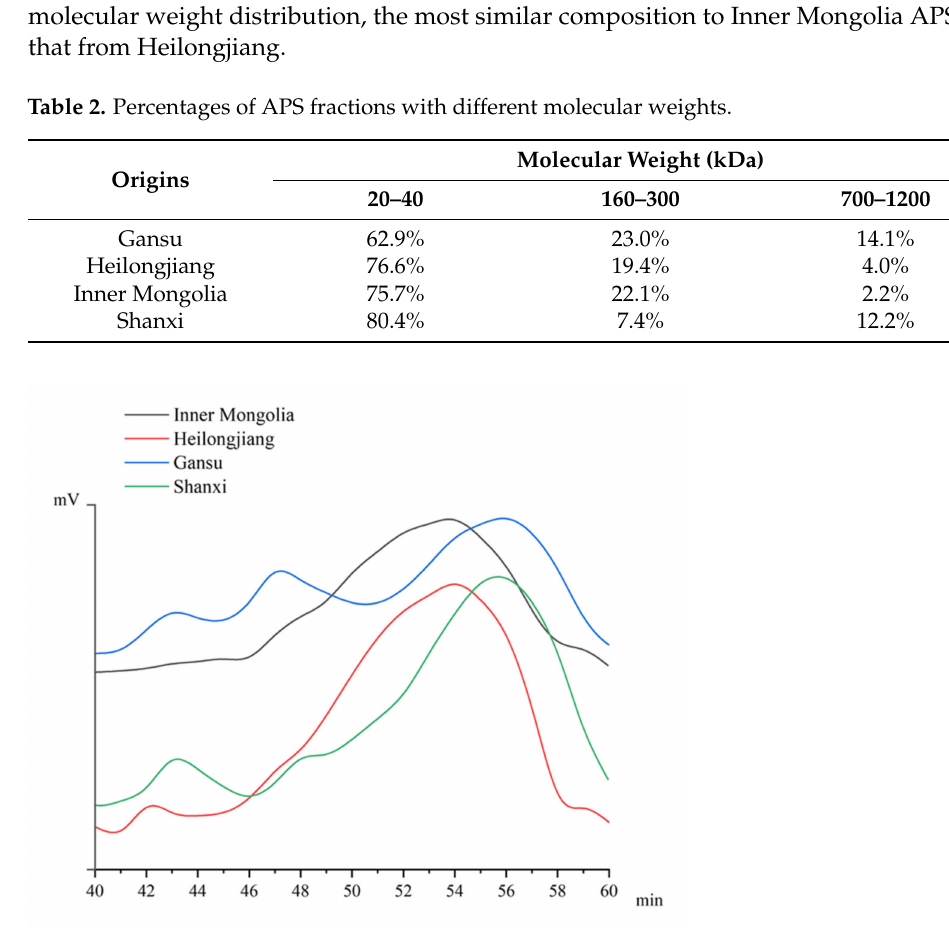
Figure 3. The molecular weight profiles of APSs from four origins (Gansu, Heilongjiang, Inner Mongolia, and